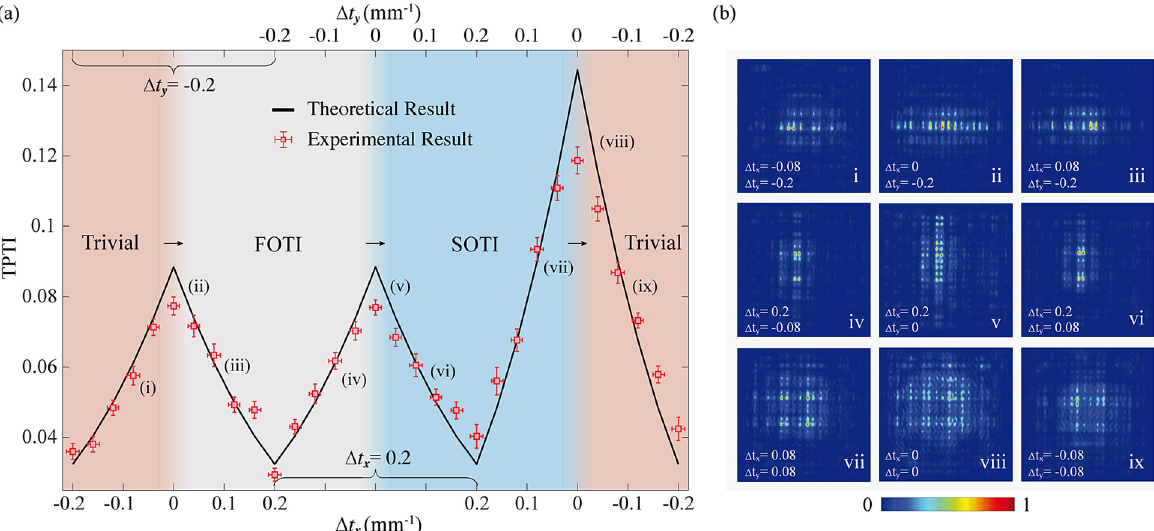
Figure 3: Experimental measurement of topological phase transition indicator. and Δ t along the triangular trajectory shown in Figure 2(b). There are three peaks at the phase (a) The measured TPTI as a function of Δ t x y transition points where the system undergoes topological phase transitions. The evolution length for all the waveguide lattices is 14 mm. The error bar is originated from the fabrication shift of the waveguide lattices. (b) Output photon distribution of the waveguide lattices with the coupling strengths chosen as (i–ix) marked in (a), corresponding to (i) trivial phase, (ii) gap closing separating trivial and FOTI phases, (iii) FOTI phase, (iv) FOTI phase, (v) gap closing separating SOTI and FOTI phases, (vi) SOTI phase, (vii) SOTI phase, (viii) gap closing = 0 . 3 mm − 1 . The unit of the coupling constants is mm − 1 . separating SOTI and trivial phases and (ix) trivial phase. The coupling strength t x , y